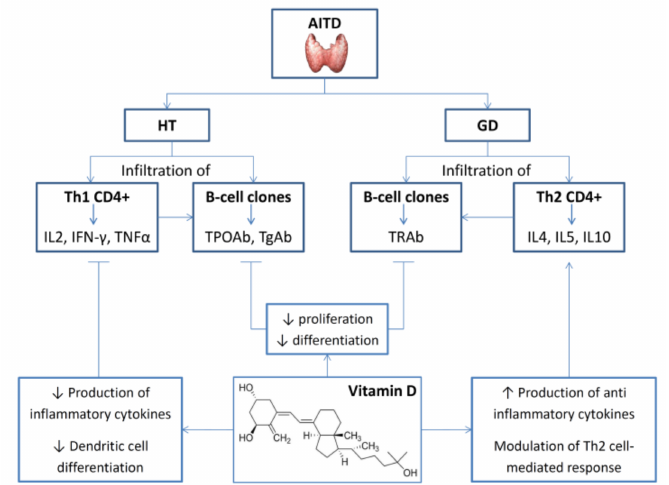
Figure 2. Hashimoto’s thyroiditis (HT) is a T-cell-mediated endocrine autoimmune disease. Patients harborhigherthyroidperoxidaseantibodies(TPOAb)andTgAbserumlevelsandthyroidintraglandular infiltration of B and T lymphocytes with CD4 + Th1 subtype predominance. Graves’ disease (GD) is characterized by a prominent Th2-mediated humoral response, which induce the expression of stimulatory antibodies. Vitamin D is able to reduce the proliferation and di ff erentiation of B cells into plasma cells and induce the apoptotic cascade of immunoglobulin. In this context, vitamin D inhibits the Th1 cells proliferation as well as the Th1-mediated cytokines production (IL-2, IFN- γ , and TNF α ) and modulates Th2 cells and cytokines production (IL-4, IL-5, and IL-10) inducing Th2 phenotype. Arrows are used to illustrate decreased ( ↓ ) or increased ( ↑ ) production of specific actions, cells or